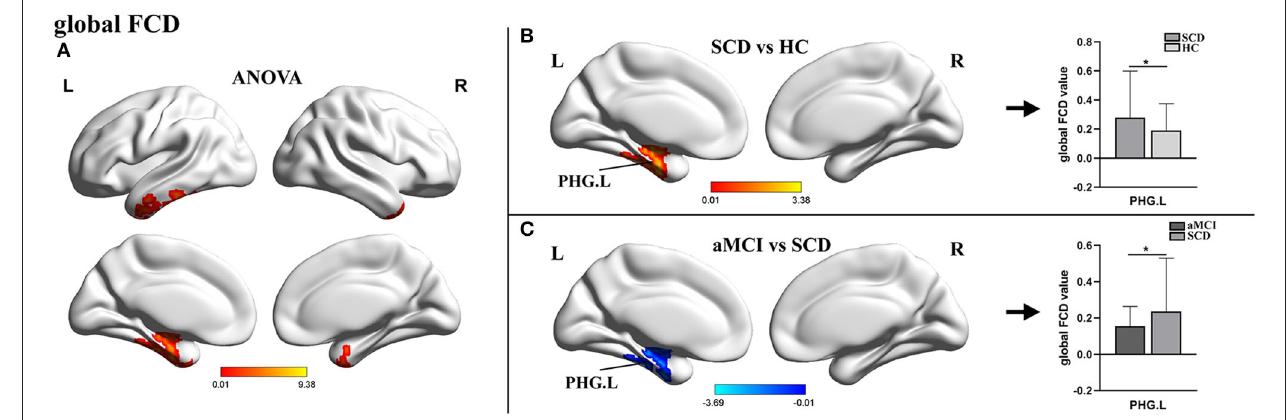
FIGURE 1 | The distribution of brain regions with statistical differences in the global FCD for SCD, aMCI, and HC. (A) Shows the results of significant differences in global FCD across three groups (one-way ANOCA, p < 0.01, the cluster size > 150 voxels). (B,C) Show the results of the post-hoc analysis across three groups (*TFCE-FWE corrected, p < 0.05, the cluster size > 50 voxels). FCD, functional connectivity density; SCD, subjective cognitive decline; aMCI, amnestic mild cognitive impairment; HC, healthy control; PHG, parahippocampal gyrus; L, left; R,